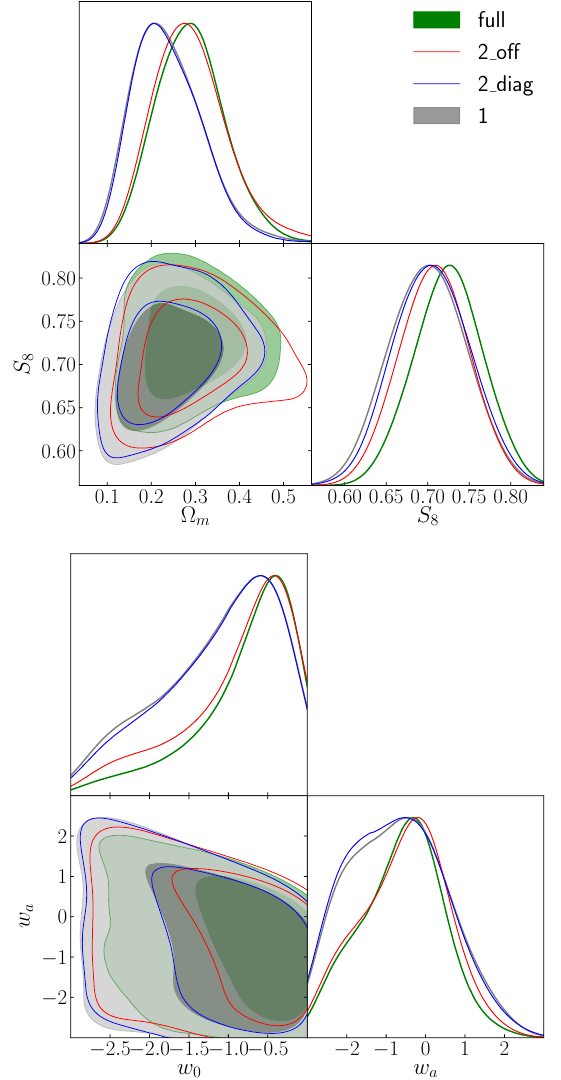
Figure 16. The same as in Figure 12 but replacing the cosmo- logical constant Λ with a time-varying equation of state, w = w 0 + (1 − a ) w a . The top panel shows the constraints in the Ω M - S 8 plane, while the bottom one shows the results for { w 0 , w a } . This extended parameter space evidences the benefits of including a second KL mode in the